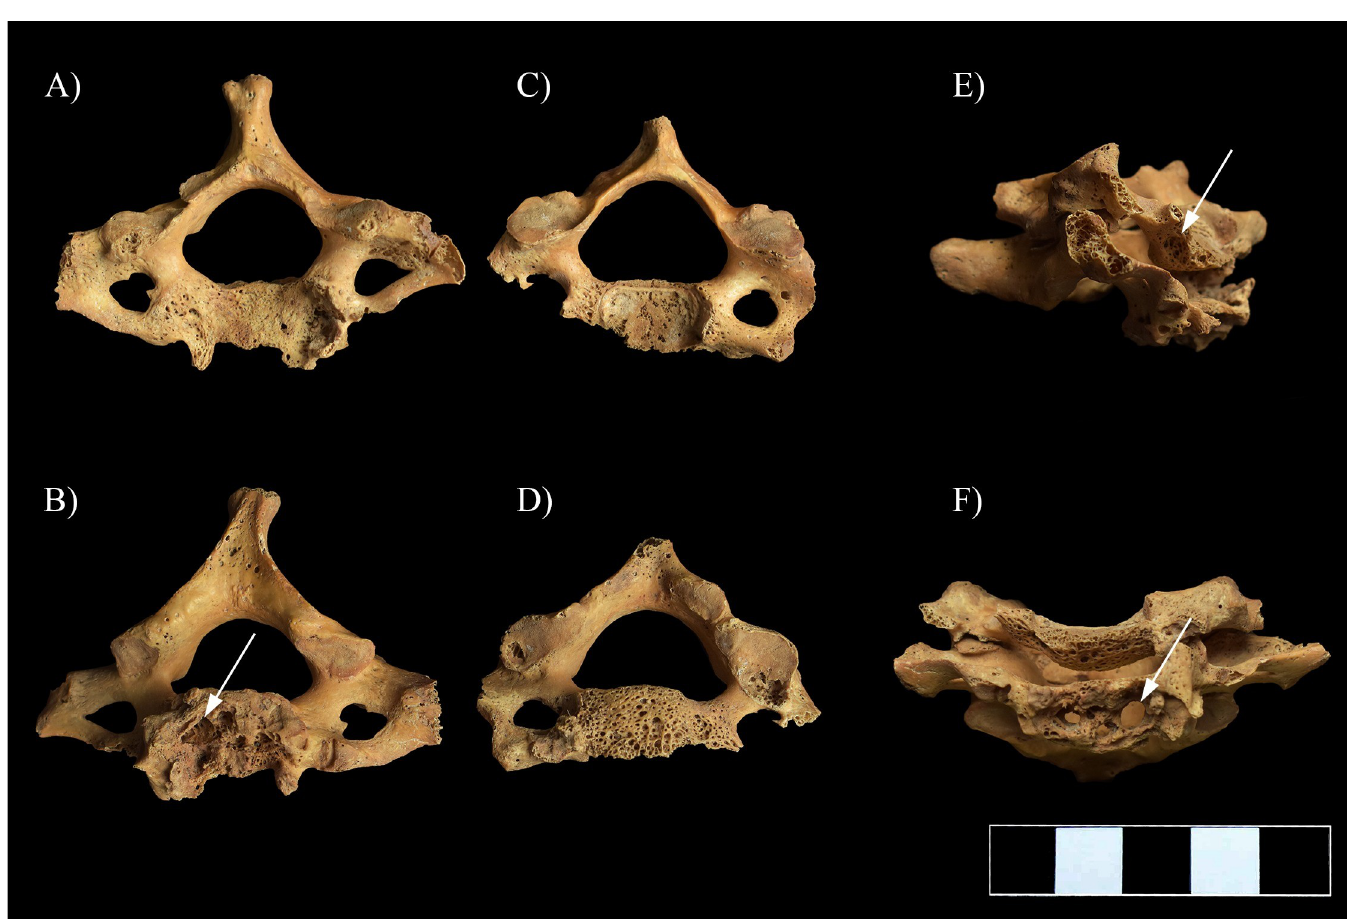
Fig 6. Multiple, well-circumscribed osteolytic lesions (white arrows) and consequent severe bone loss in the C6–7 vertebrae. A) Superior view of C7, B) Inferior view of C7, C) Superior view of C6, D) Inferior view of C6, E) Lateral view of C6–7 (right side), and F) Anterior view of